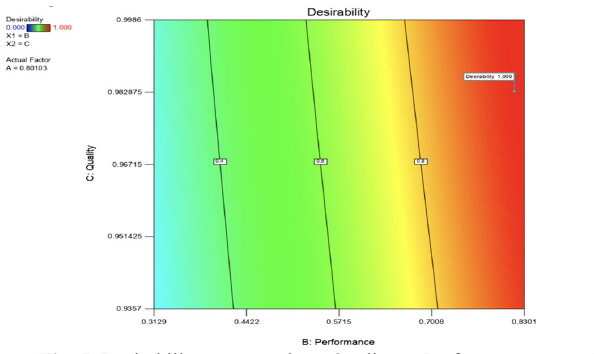
Fig. 5. Desirability contour plot – Quality vs Performance Fig. 6. Desirability contour plot – Performance vs Availability